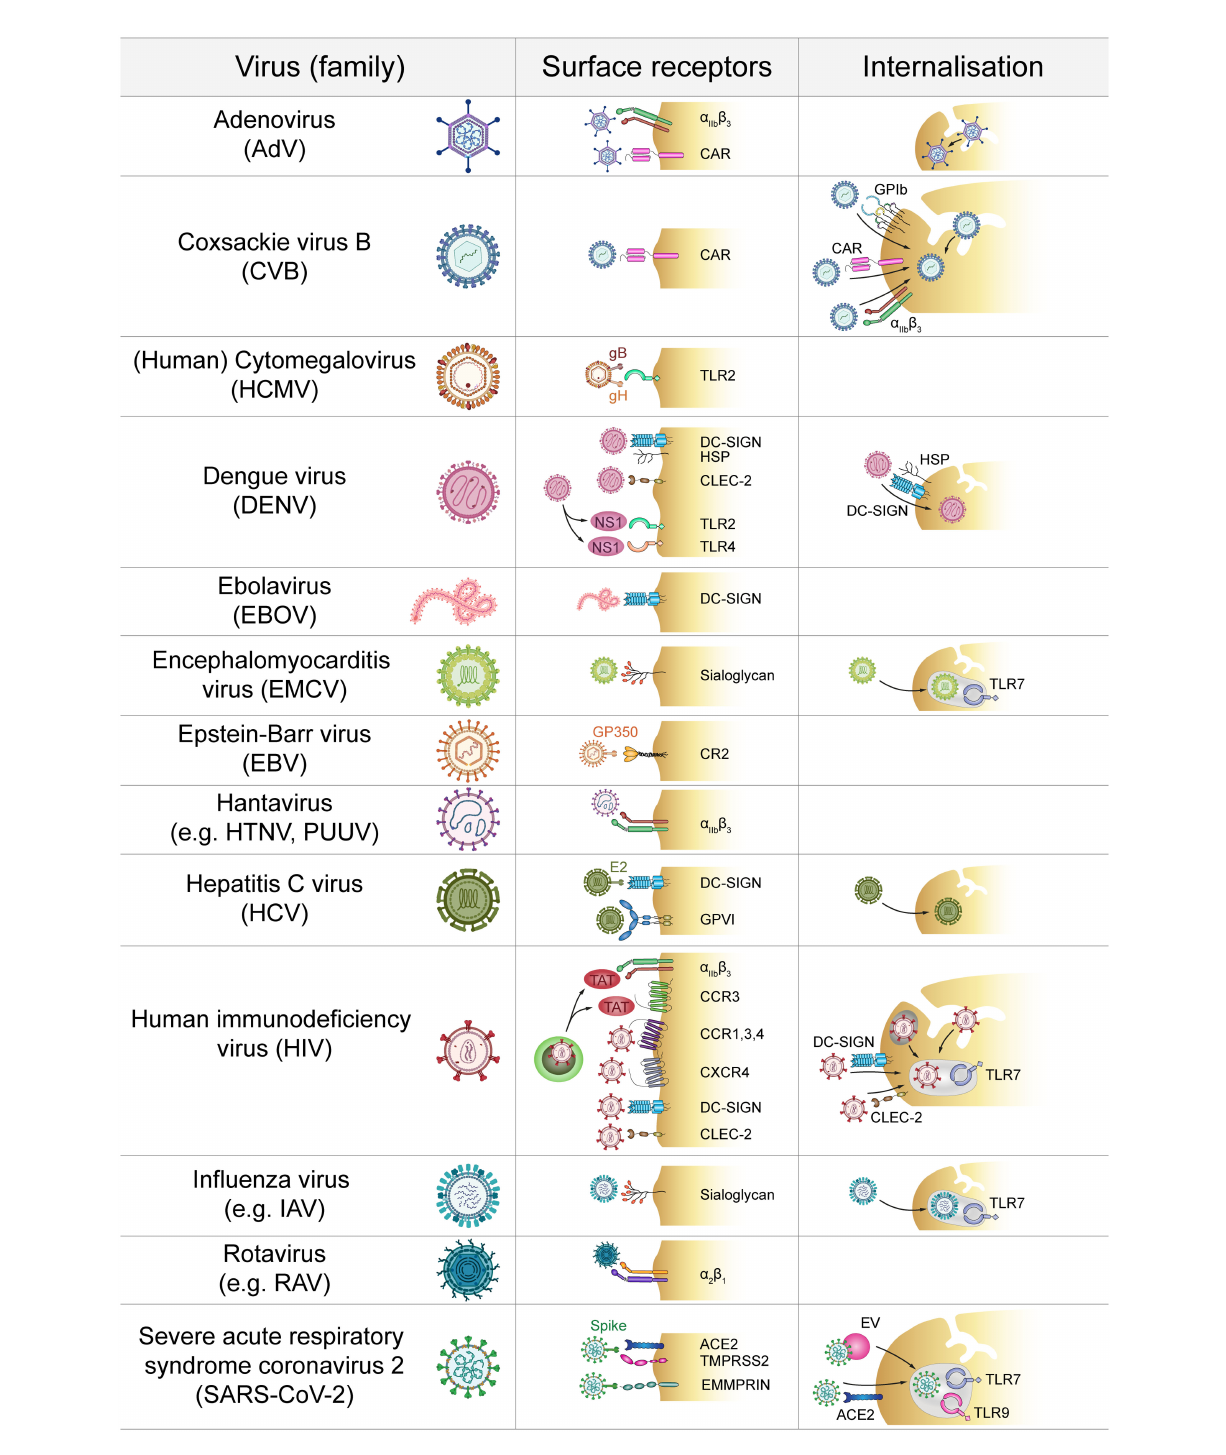
FIGURE 1 | Direct platelet-virus interactions. Platelets express a plethora of surface receptors to directly bind variousvirus families. Subsequent virusinternalisation may occur via the cellsurfaceorthe open canalicular system.ACE2, Angiotensin-converting enzyme 2; CAR, CoxsackieandAdenovirus receptor;CCR, C-C chemokine receptor; CLEC-2, C-type lectin receptor 2; CR2, Complement receptor2; CXCR, C-X-C chemokine receptor;DC-SIGN, Dendritic cell-speci fi c intercellular adhesion molecule-3-grabbing non-integrin;GP, Glycoprotein; HSP, Heparan sulfate proteoglycan;HTNV, Hantaan virus; IAV, In fl uenza A virus; EMMPRIN, extracellular matrix metalloproteinase inducer;EV, Extracellular vesicle; NS1, Non-structural protein 1; PUUV, Puumalavirus; RAV, Rotavirus A; TAT, Trans-activator of transcription;TLR, Toll- likereceptor; TMPRSS2, Transmembrane protease serine subtype